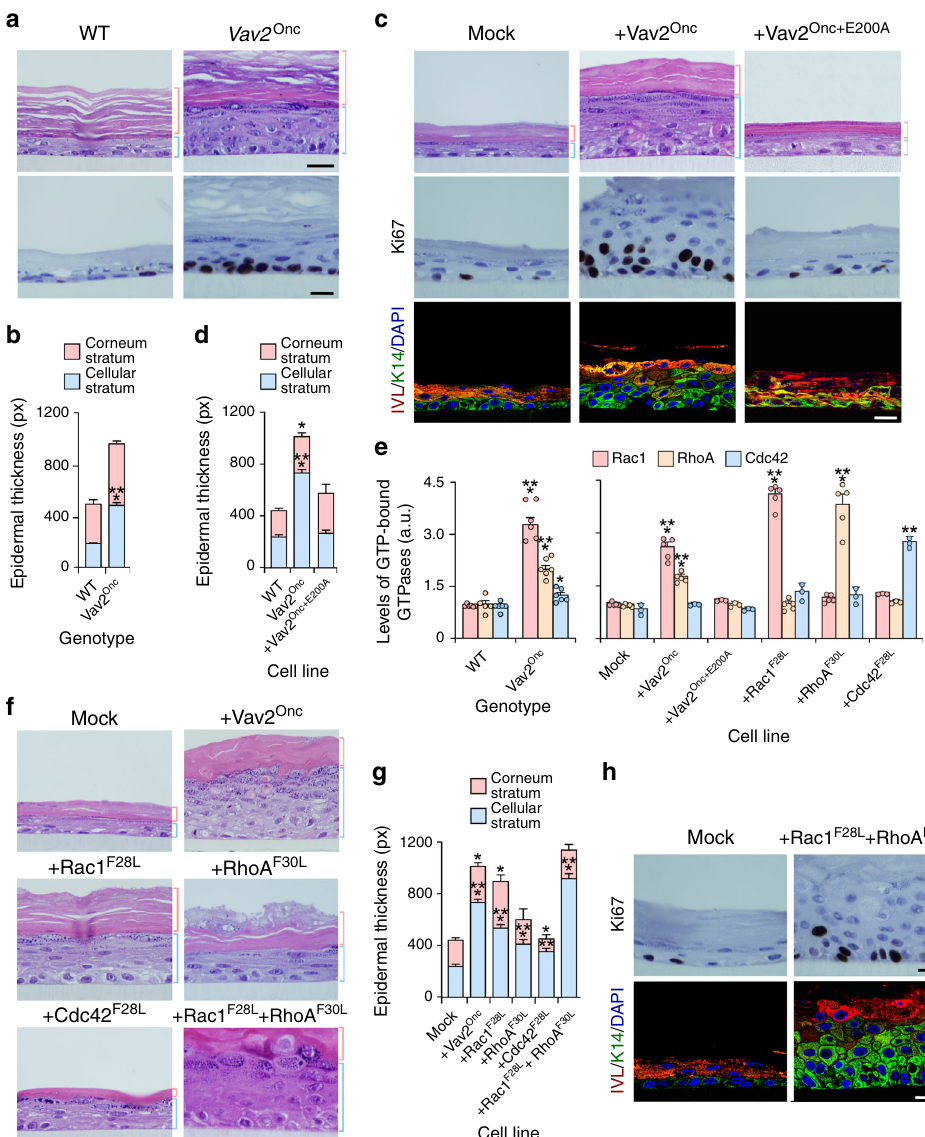
Fig. 4 The effect of Vav2 in epidermis is keratinocyte autonomous. a Hematoxylin-eosin- (top) and Ki67- plus hematoxylin-stained (bottom) tissue sections from organotypic cultures using neonatal keratinocytes of indicated genotypes. The thickness of the corneum and cellular epidermal strata is indicated with red and blue brackets, respectively. Scale bar, 10 μ m ( n = 6 independent cultures). b Thickness of the indicated skin strata according to data from a . *** P < 0.0001 (two-tailed Student ’ s t -test, n = 6 independent cultures). c Representative images of indicated organotypic cultures after staining with hematoxylin-eosin (top panels) and antibodies to Ki67 (middle panels), involucrin (IVL, bottom, red color), and keratin 14 (K14, green color). Some of the sections were subsequently counterstained with either hematoxylin (middle row of panels) or DAPI (bottom panels, blue color). Scale bar, 10 μ m. n = 8 (Mock and Vav2 Onc ) and 5 (Vav2 Onc + E200A ). d Thickness of the indicated skin strata according to data obtained in c . * P = 0.029; *** P < 0.0001 (two- tailed Student ’ s t -test, n as in panel c). e GTP-bound levels of Rac1, RhoA, and Cdc42 in indicated cells. * P = 0.013; ** P = 0.002; *** P < 0.0001 (ANOVA and Tukey ’ s HSD test, n = 3 independent experiments). f Histological sections of 3D cultures of human keratinocytes expressing indicated proteins. Scale bar, 10 μ m ( n = 5 independent cultures). g Thickness of the indicated epidermal strata according to data from f . * P = 0.047 (Vav2 Onc corneum stratum), 0.011 (Rac1 F28L corneum stratum), 0.033 (Cdc42 F28L corneum stratum); ** P = 0.003 (Cdc42 F28L cellular stratum); *** P < 0.0001 (all other tests) (ANOVA and Dunnett ’ s multiple comparison test, n = 5 independent cultures). h Immunohistochemical staining of mock- and Rac1 F28L + RhoA F30L - expressing human keratinocytes with antibodies to Ki67 (top panels), IVL (bottom, red color) and K14 (bottom, green color). Sections were counterstained with either hematoxylin (top panels) or DAPI (bottom panels, blue color). Scale bar, 10 μ m ( n = 3). In b , d , e , and g , data represent the mean ± SEM. Source data for this fi gure are provided as a Source Data fi